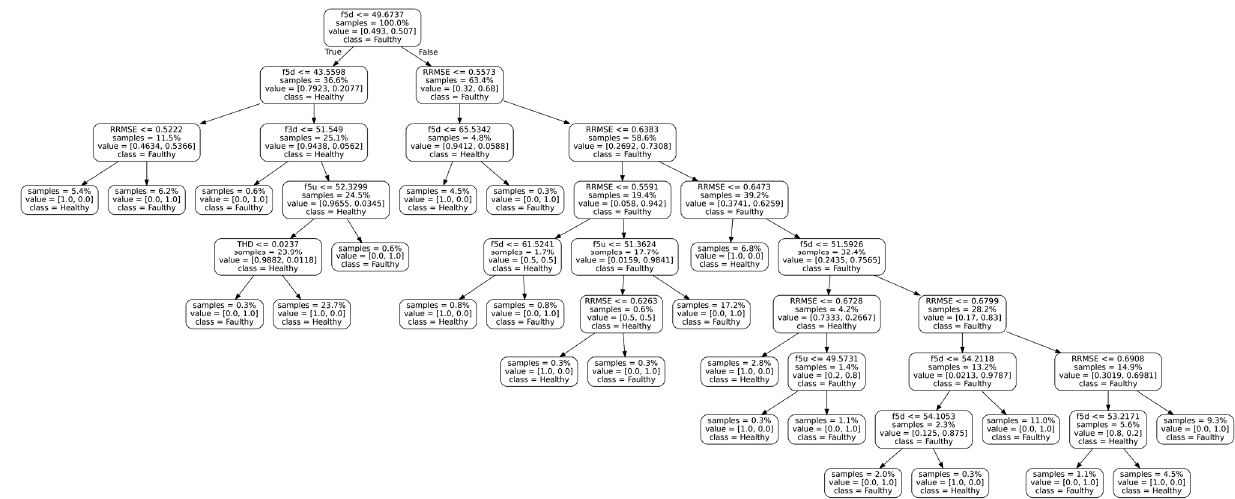
Figure 11. Decision tree model developed.